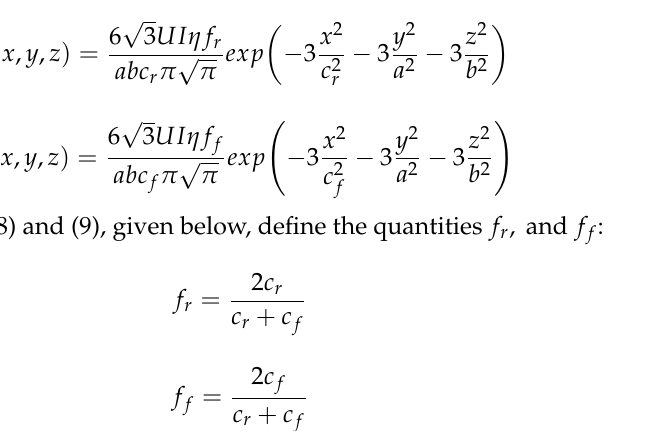
Figure 6. Double ‐ ellipsoidal heat source model. Figure 6. Double-ellipsoidal heat source model. Furthermore, UI η is the energy transferred to the welded structures from the torch, a is the radius along the transverse axis ( y -axis) of the half-ellipsoid, b is the radius along the z -axis of the half ellipsoid, and f f and f r are the fractions of the energy that are applied to the front and rear of the torch. As with arc pressure, heat flow is strongly influenced by several factors such as current, voltage, radial distance, process efficiency, shielding gas, and electrode grinding